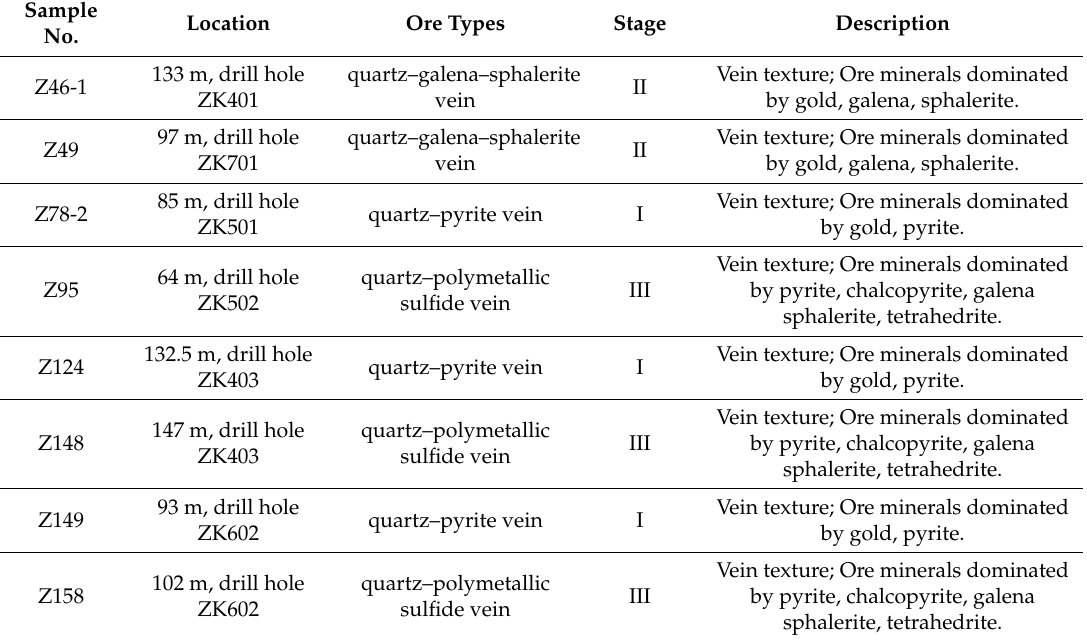
Table 1. Location and descriptions of samples for H–O isotope testing from the Xiajinbao Au deposit. Sample